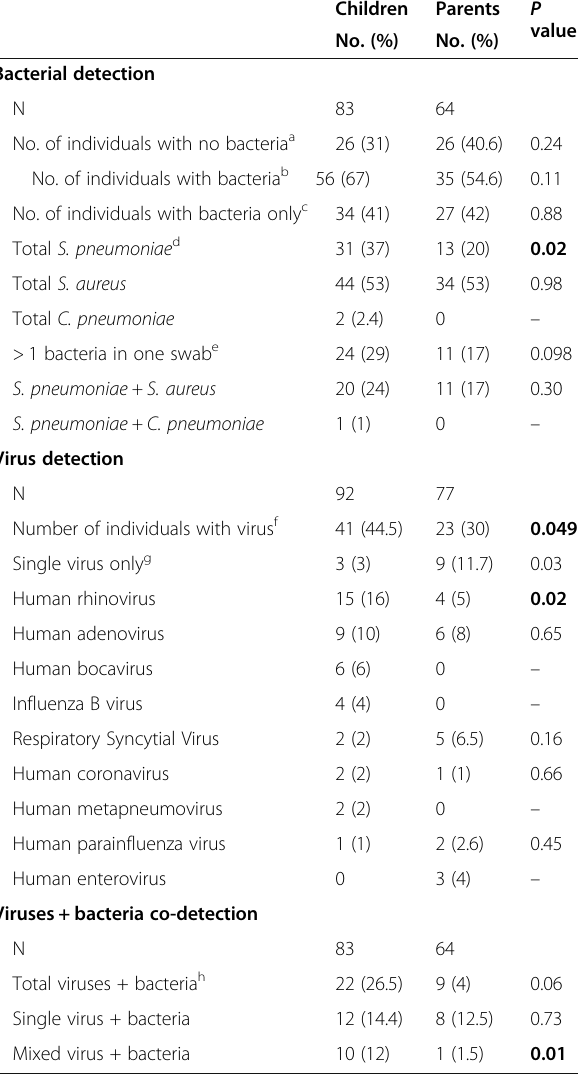
(Table 4). Samples for bacterial testing were lower due to the loss of reactions in bacterial standards.